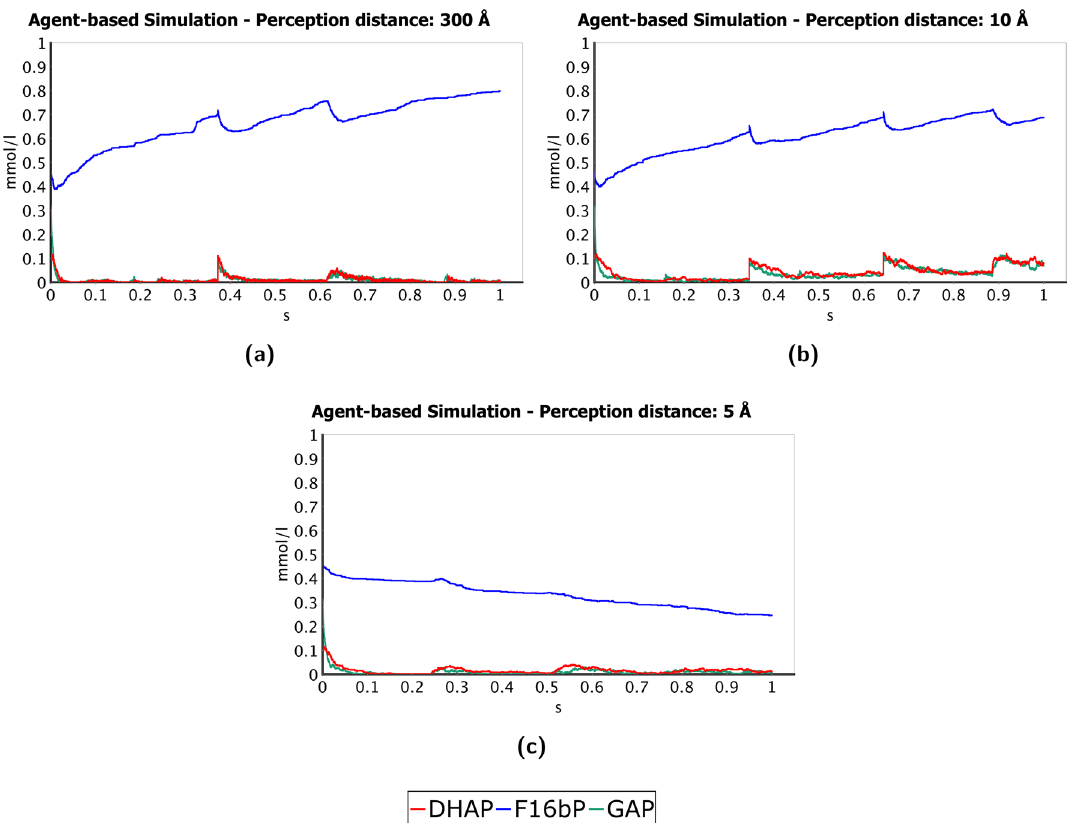
Figure 4. Synchronised oscillation-like fluctuations observed in fructose 1,6-bisphosphate ( F16bP ), dihydroxyacetone phosphate ( DHAP ) and glyceraldehyde 3-phosphate ( GAP ). The first metabolite is the product of the phosphorylation of fructose-6-phosphate , catalysed by phosphofructokinase , while the other two are generated by the subsequent reaction in the glycolytic pathway, carried out by fructose-bisphosphate aldolase . DHAP and GAP are also interconverted by the triosephosphate isomerase . In ( a,b ), that is, the plots of the simulations that take into account the electromagnetic forces (limited or not by the Debye screening), we can observe an oscillatory trend with a frequency of about 2.8 s − 1 , synchronised in all the three curves. Conversely, in the simulation that considers just short-range electrostatic interactions, shown in plot ( c ), these oscillations are almost unnoticeable. The higher frequency measured experimentally in yeast’s glycolysis 35 is of 30 s − 1 ; therefore, at the time scale of our simulations, these can be considered more as micro-oscillations, which give us a clue of the higher faithfulness to the real glycolytic process of the models whose interactions are not limited to just random encounters and chemical